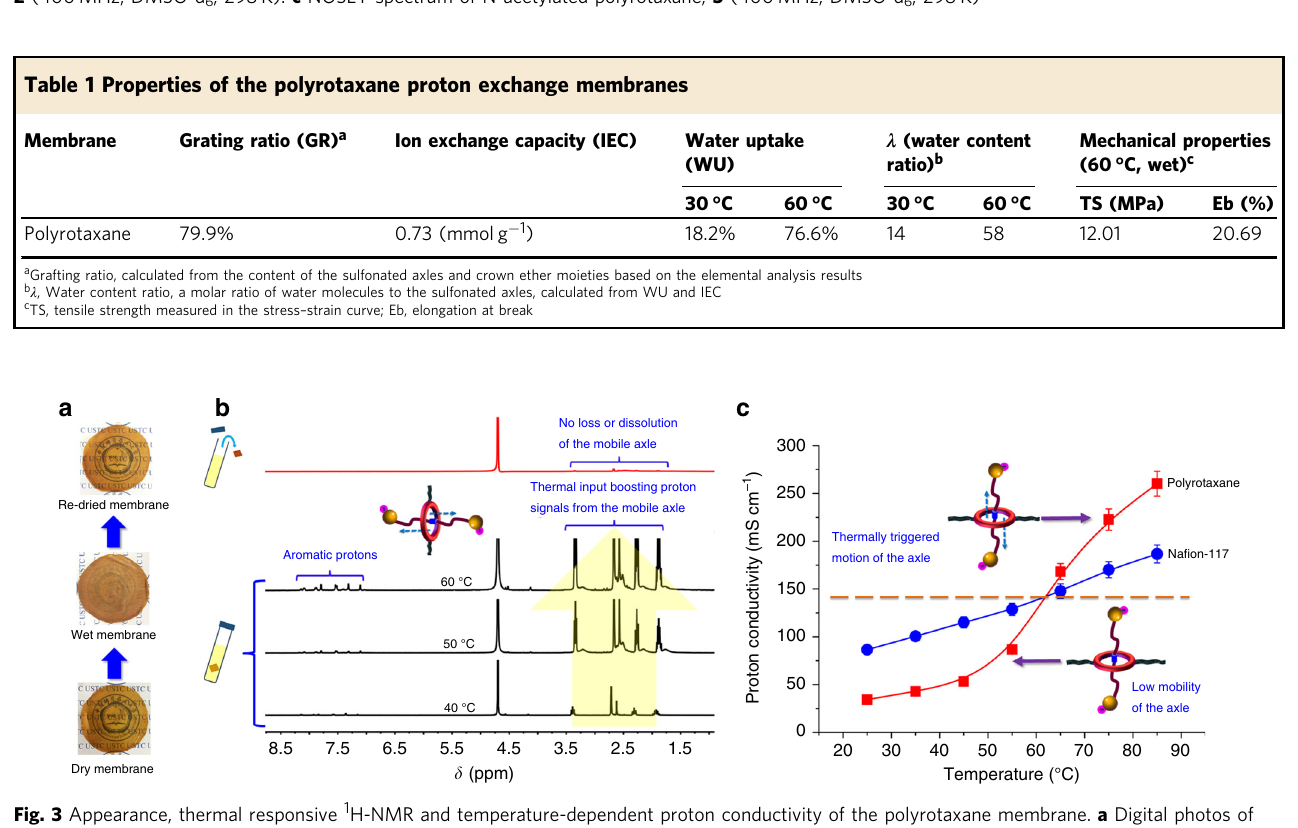
Fig. 3 Appearance, thermal responsive 1 H-NMR and temperature-dependent proton conductivity of the polyrotaxane membrane. a Digital photos of polyrotaxane membrane samples, showing the thermal responsive transparency change in membrane appearance, from bottom to top: dry membrane sample, hydrated membrane sample (treated in 60 °C water for 2 h) and re-dried membrane sample. b 1 H-NMR spectra (400 MHz, D 2 O) of membrane samples immersed in D 2 O as the temperature was increased from 40 to 60 °C, and spectrum recorded from the same NMR tube after removing the membrane sample (top spectrum). c Proton conductivities of polyrotaxane membrane and the benchmark Na fi on-117 as a function of temperature. The error bars represent the s.d. from three independent measurements